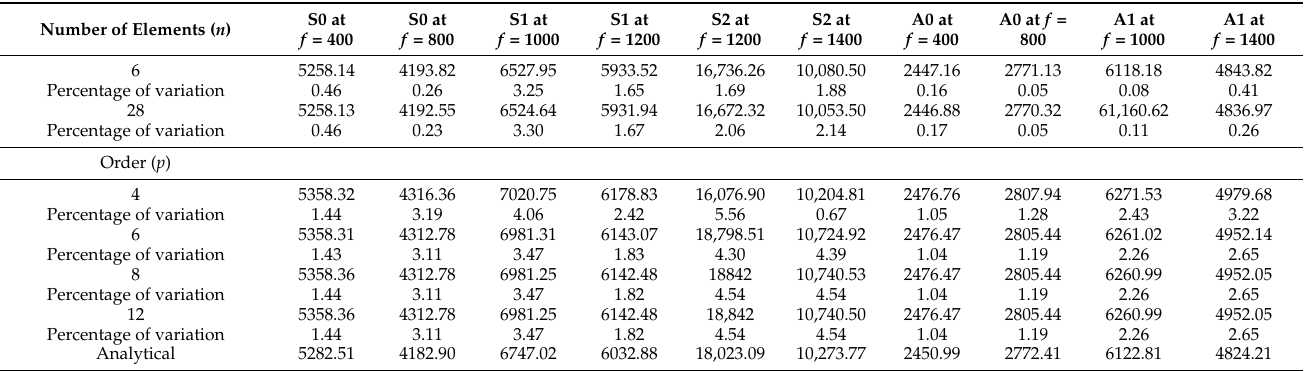
Table 3. Percentage of variation of Cp (m/s) for modes S0, S1, A0 and A1 for specific frequencies as a function of the number of elements n. Frequency f in kHz.